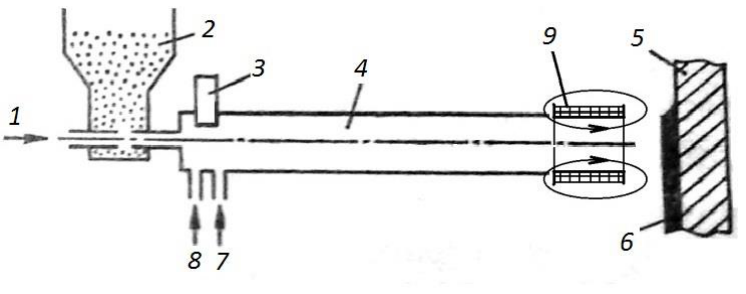
Fig. 1. Magnet modified detonation installation simplified diagram: